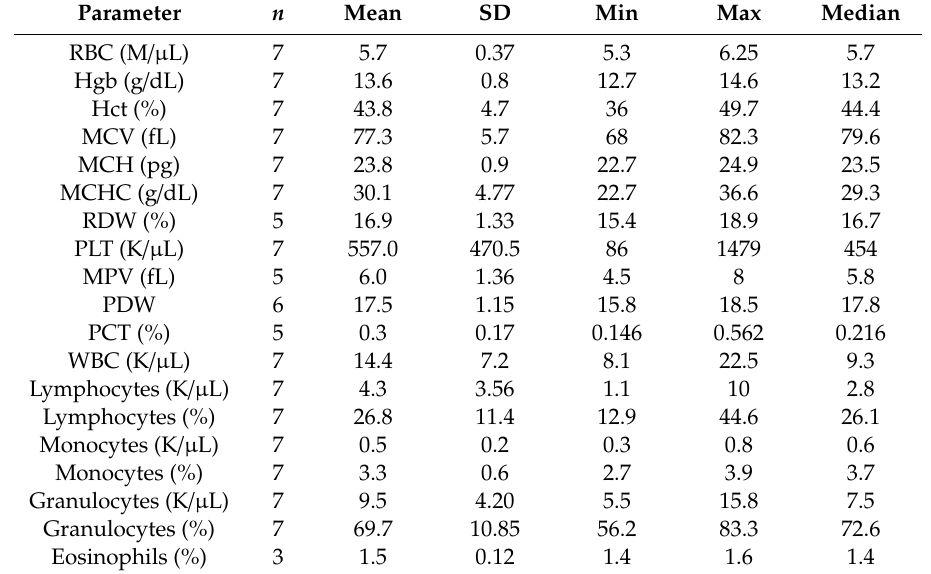
Table 3. Hematological profile of the crested porcupine. For each parameter, the mean, the standard deviation (SD) minimum (Min) and maximum (Max) value, and the median are